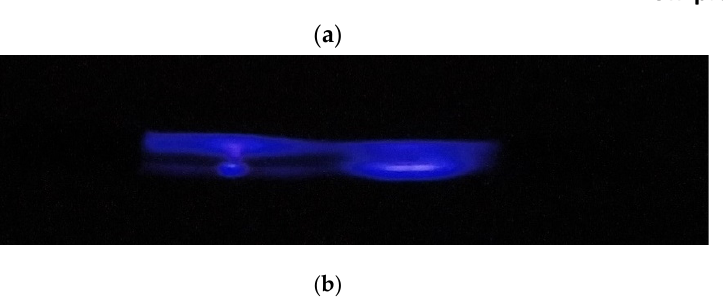
Figure 3. ( a ) Experimental setup sketch including the used instrumentation. The distance between the gas-filled sensors and the wire electrode is approximately 50 mm, whereas the distance between the CMOS image sensor and the wire is approximately 90 mm; ( b ) photograph of an early-stage discharge at 10 kPa when applying 700 V RMS and 400 Hz, appearing in the surroundings of the notch sites. notch